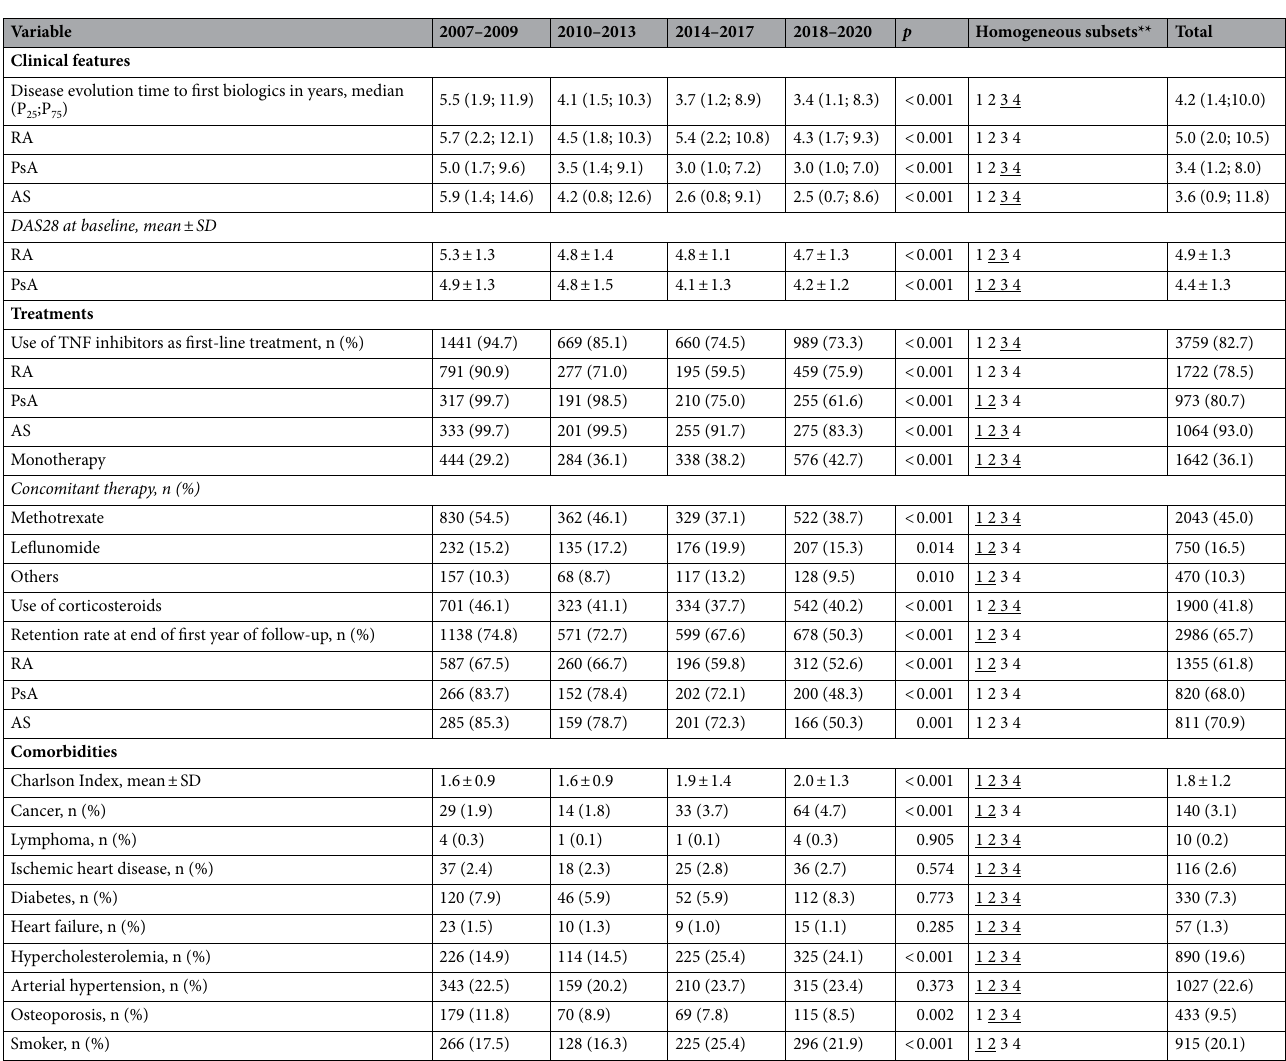
Table 2. Clinical features and use of treatments at the beginning of first-line biologics treatment by time periods. *Centers that included at least one patient in this analysis. **Numbers in the homogeneous subsets column represent the four consecutive periods of time. Lines join time periods in which differences were not statistically